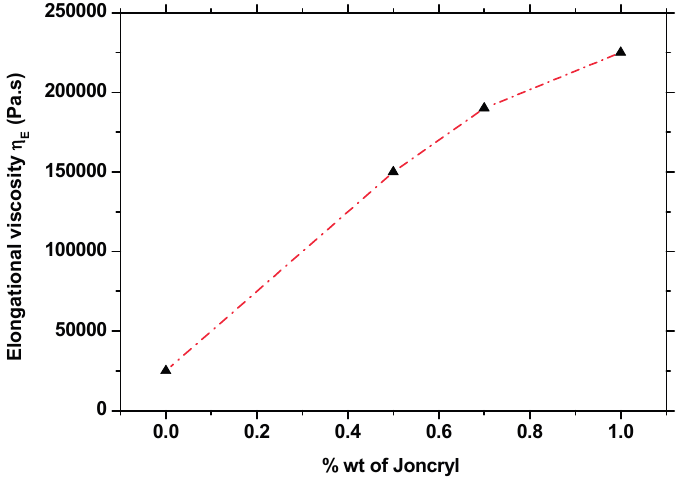
Figure 7. Example of the evolution of the elongational viscosity at 180 °C given by Cogswell method versus the Joncryl ® amount of the modified PLA at 30 s − 1